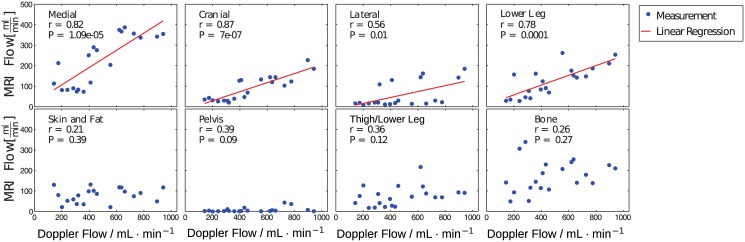
Correlation of the corrected DCE-MRI model results.Correlation of the corrected DCE-MRI model results with the Doppler flow values for the F-test selection method in the different muscle segments. The measurements are plotted using blue dots and the significant correlations (P<0.05) using a red line.